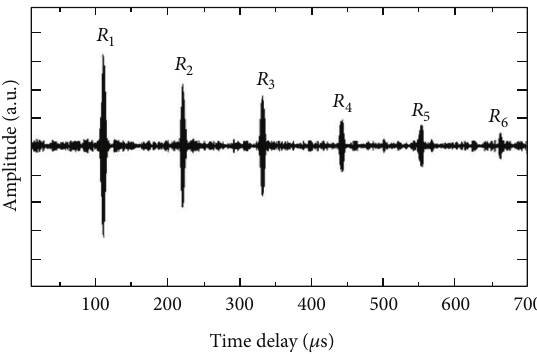
Figure 9: Rayleigh surface acoustic wave signal generated and detected with the IDT shown in Figure 8 at 150 ∘